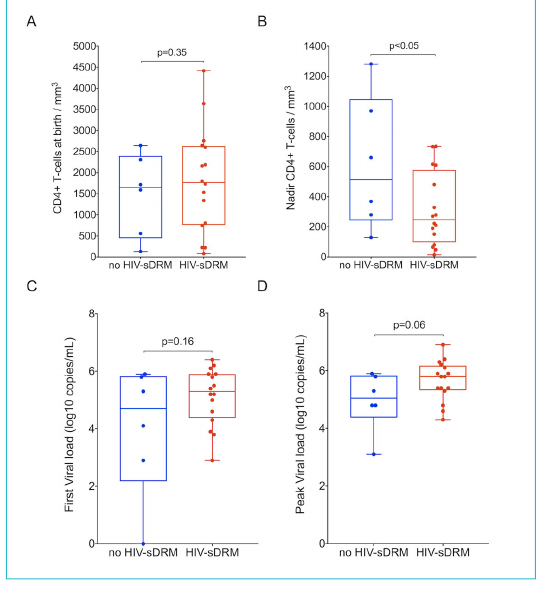
Figure 3: HIV load and CD4 T-cell count in vertically HIV-in- fected children. A. CD4 T-cell count in MTCT children at birth with and without selected HIV drug resistance mutations (HIV-sDRM). B. Nadir CD4 T-cell count in MTCT children with and without HIV- sDRM. C. First HIV-1 load in MTCT children with and without HIV- sDRM. D. Peak HIV-1 load in MTCT children with and without HIV- sDRM. Box and whiskers plots showing median and 25th and 75th percentiles.